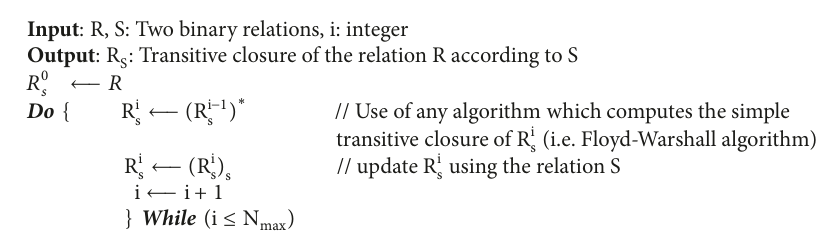
Algorithm 1: Algorithm skeleton of transitive closure computation (R S ).